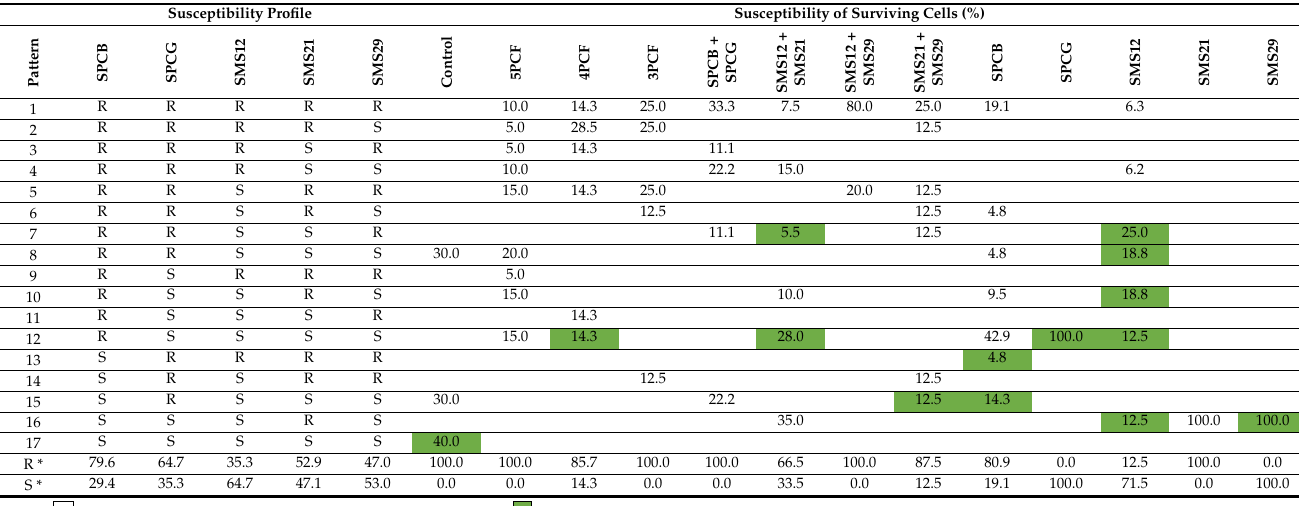
Table 3. Susceptibility of P. aeruginosa surviving cells recovered after 24 h from the different time–kill experiments with different phage combinations.